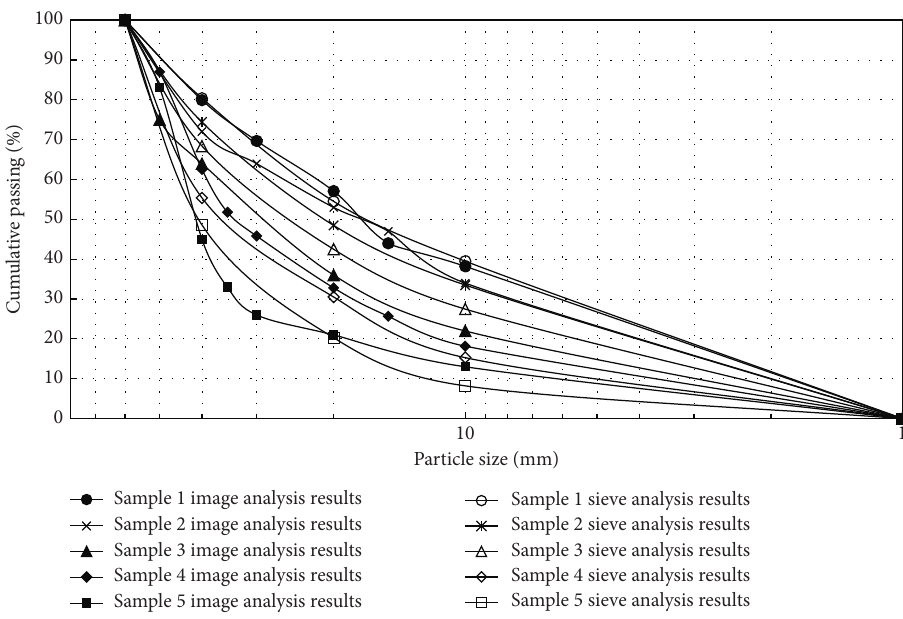
Figure 7: Gradation curves of limestone aggregate (samples 1 to 5); standard sieve analysis versus image analysis results.